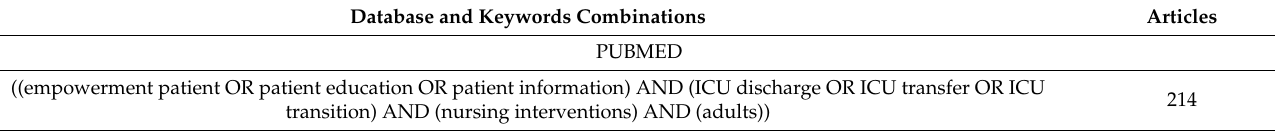
Table 1. Terms of searching in the different databases and results obtained. Database and Keywords